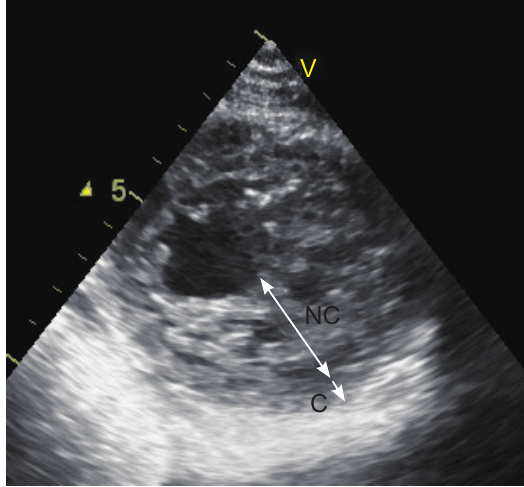
Figure 8 Left ventricular short-axis view from echocardiography: the ratio of thickness between non-compacted layer (NC) to compacted layer (C)